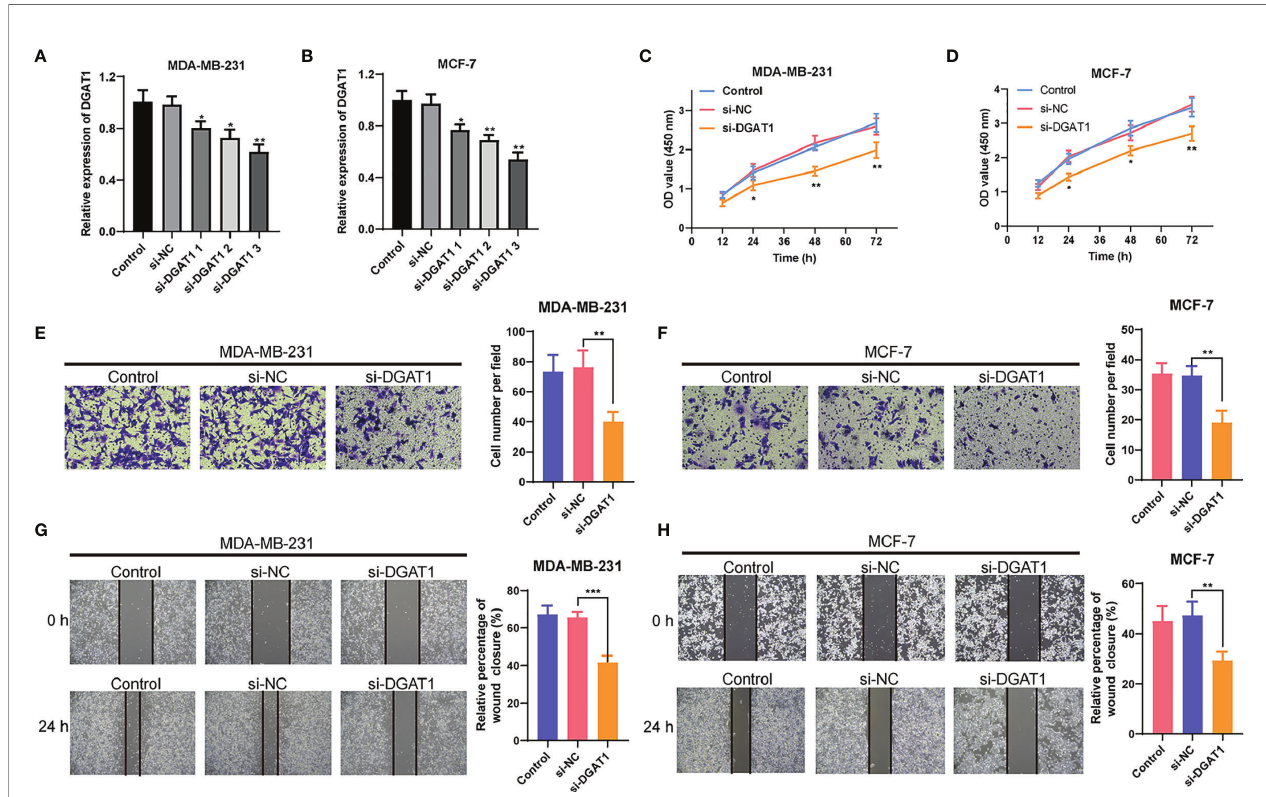
FIGURE 12 | The effect of DGAT1 on proliferation and migration of breast cancer (BC) cells. (A, B) The results of qRT-PCR showed that siRNAs could successfully knock down the expression of DGAT1 in MCF-7 and MDA-MB-231. (C, D) The depletion of DGAT1 observably suppressed the proliferation ability in both MCF-7 and MDA-MB-231 compared with the si-NC group. (E – H) The knockdown of DGAT1 could signi fi cantly decrease the migration of MCF-7 and MDA-MB-231 BC cells. *P < 0.05; **P < 0.01; ***P <